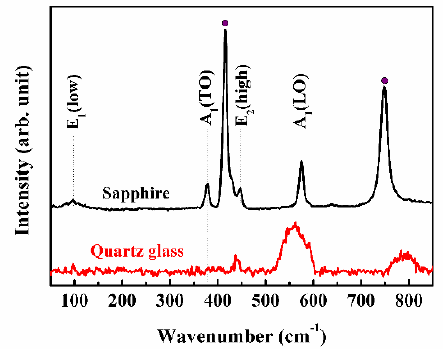
Figure 7. Raman spectra of the as-received ZnO thin films grown on the quartz glass and sapphire substrates, respectively.